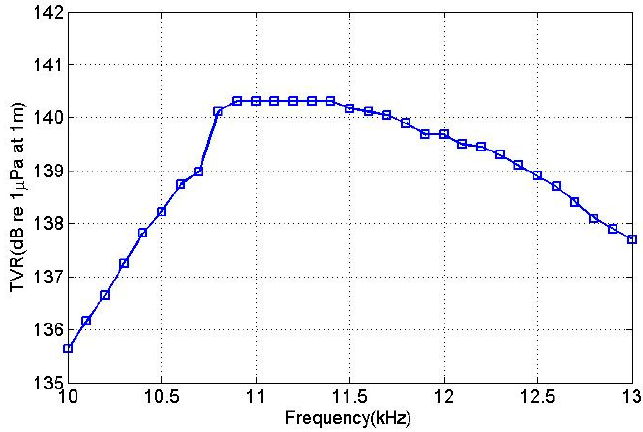
Figure 14. Transducer emission voltage response curve.